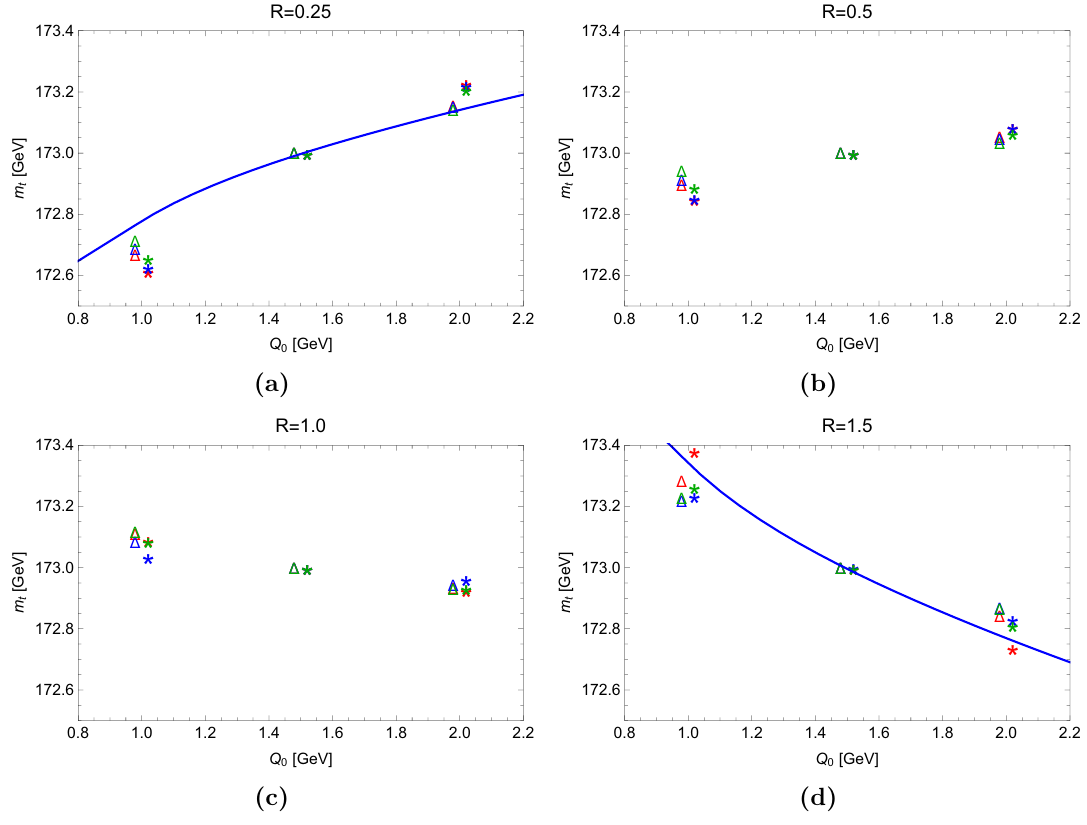
Figure 16. Fitted top quark mass as a function of the shower cut Q 0 = Q 0 ;b for Q = 700 GeV obtained from the m b endpoint (stars) and the m b resonance region (triangles) using the k t - j ‘ j W type-type algorithm (green), the Cambridge-Aachen-type algorithm (blue) and the anti- k t -type algorithm (red) for b -jet clustering. Displayed are the results for b -jet radii R = 0 : 25, 0 : 5, 1 : 0 and 1 : 5. The solid blue line in the lower right panel corresponds to eq. (7.5) and the one in the upper left panel corresponds to eq. (7.6) using Q 0 = 1 : 5 as the reference scale. 0